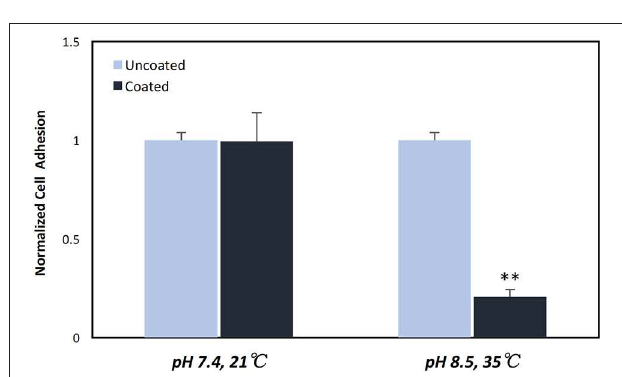
FIGURE 7 | P. cryohalolentis bacterial adhesion on coated and uncoated standard finish SS coupons. Coatings were created in pH 7.4 at 21 ◦ C and pH 8.5 at 35 ◦ C. Normalized bacterial adhesion of P. cryohalolentis to the surface of 316L SS coupons after 24h showed no significant change with the pH 7.4 solution, however, there was a significant reduction in bacterial adhesion on the surface of SS coupons with the pH 8.5 coating. **A significant difference from both the uncoated SS and the other coating condition ( p < 0.001) using a standard one-way ANOVA t